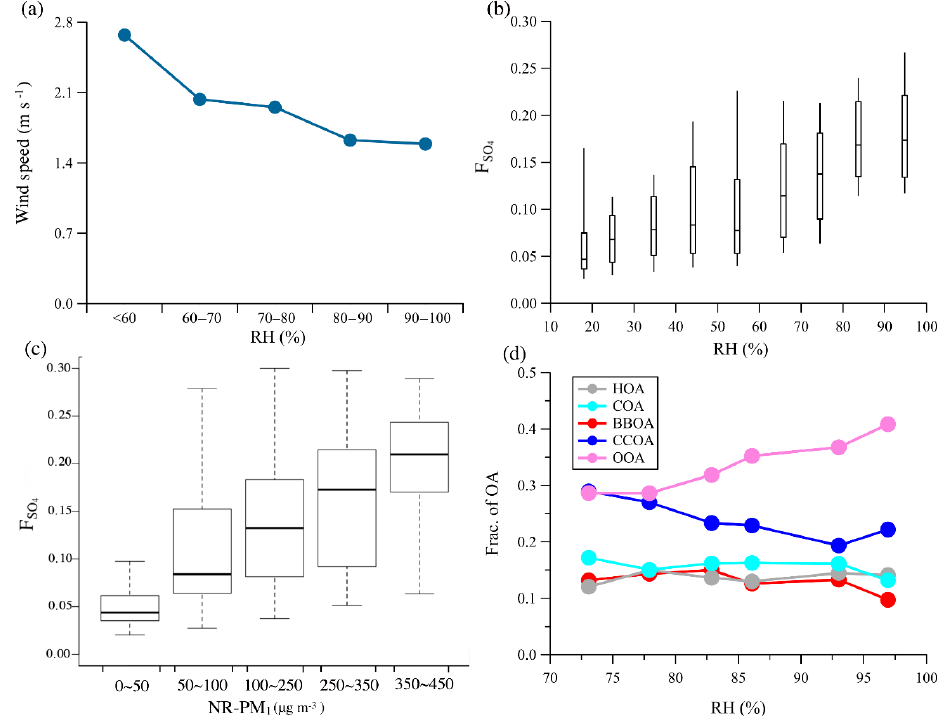
Figure 6. Variations of wind speed as a function of RH (a) , F SO the mass fraction of OA as a function of RH (d)